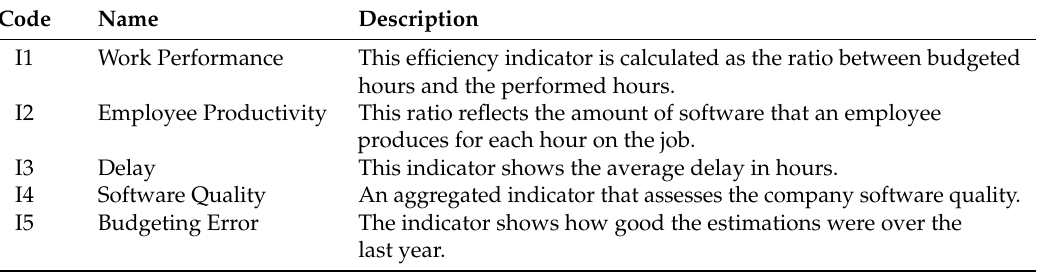
Table 3. Summary of the internal business processes’ perspective key performance